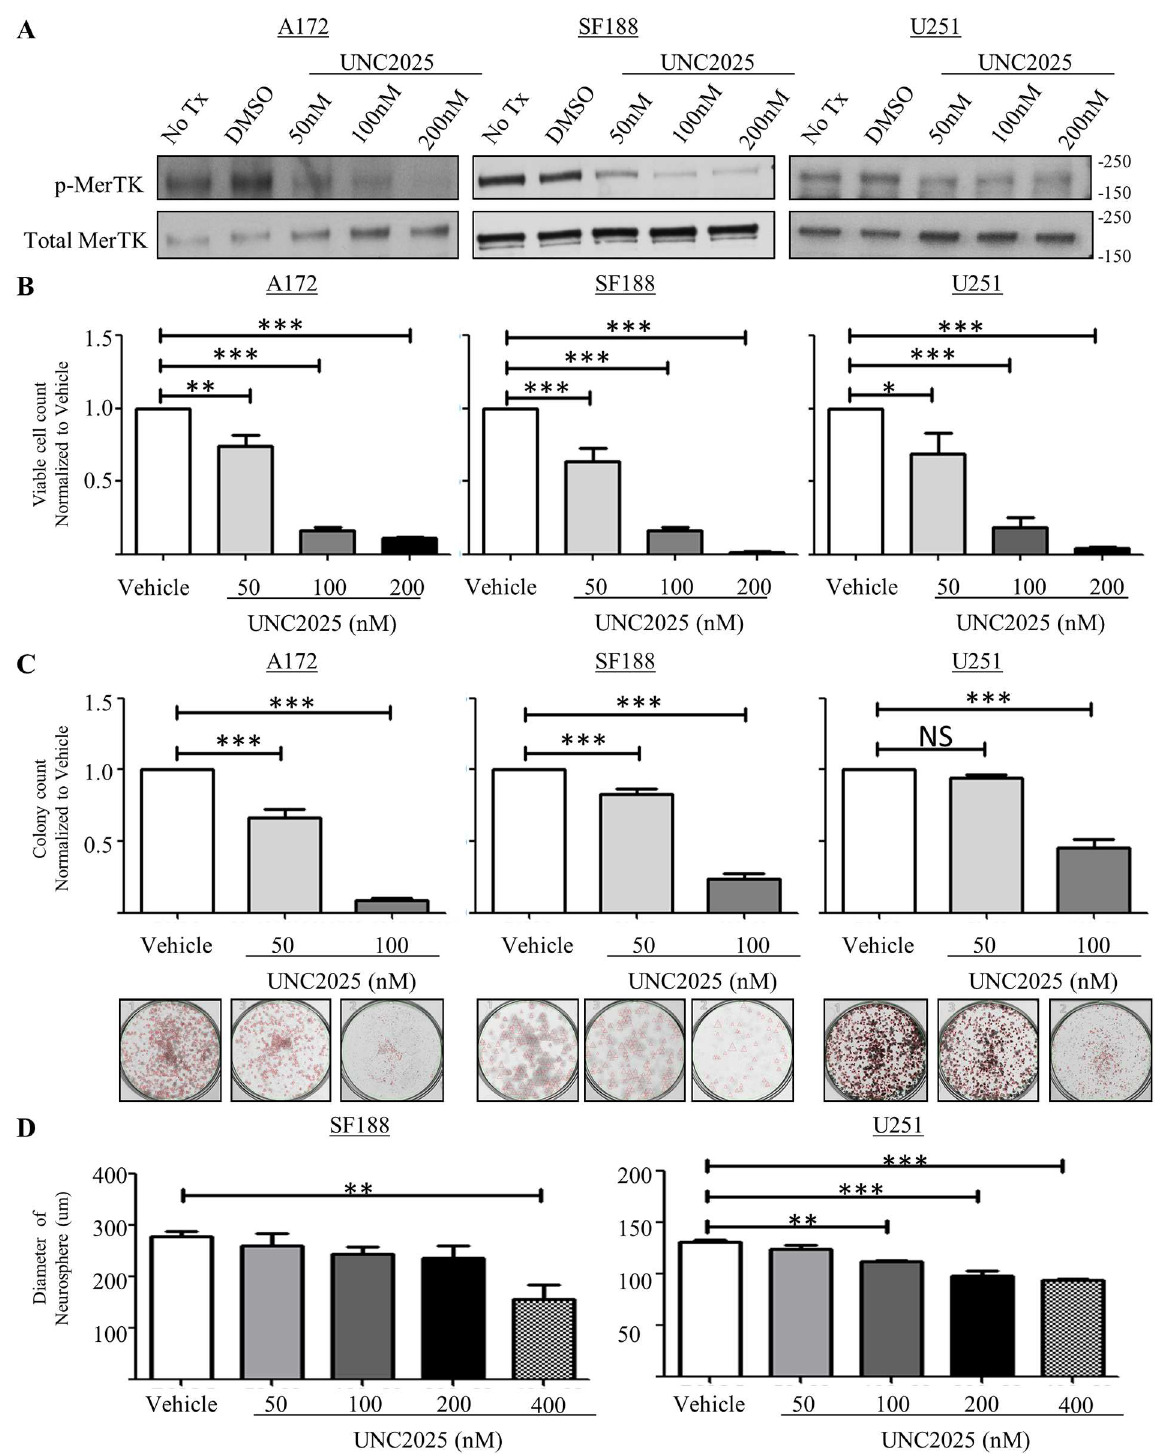
Fig 2. UNC2025 inhibits phosphorylation of MERTK in GBM cells leading to reduced cell number, colony-forming potential, and neurosphere diameter. (A-B) GBM cell lines A172, SF188, and U251, were treated with UNC2025(50nM, 100nM, 200nM), 200nM UNC2369(a negative control TKI with similar structure to UNC2025 but lacking MERTK inhibitoryactivity), or vehicle (DMSO) for one hour. MERTK protein was immunoprecipitated from cell lysates and phosphorylated MERTK protein was detected by immunoblot. (A) Representative images from three independent experiments are shown. (B) Phosphorylated and